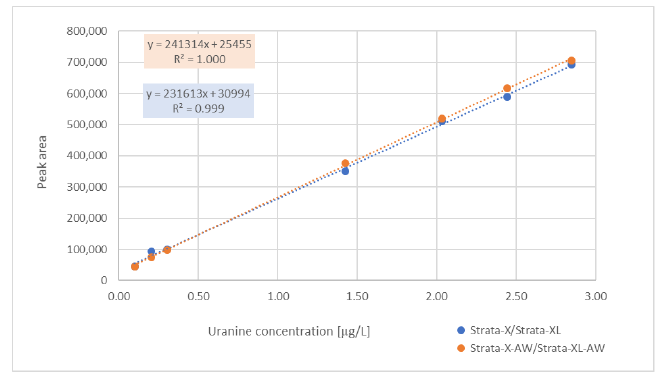
Figure 1. Standard curves obtained for the two types of extraction columns tested. At the concentration range of 0.1 – 2.8 µg/L, the obtained graphs took the form of a linear function. Both types of tested columns were suitable for the extraction of uranine to the solid phase. Due to the higher availability, Strata-X/Strata-XL Reversed Phase for Neutral Compounds columns from Phenomenex were used for the studies performed in this research.